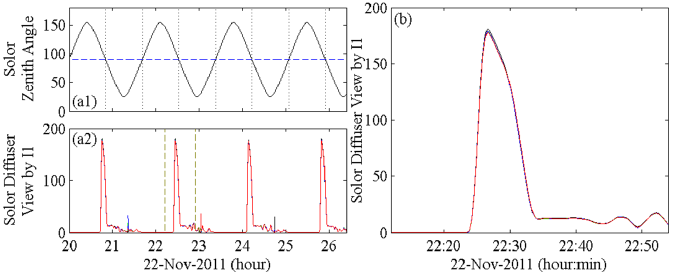
Figure 2. ( a1 ) Spacecraft solar zenith angle and ( a2 ) solar light illumination of VIIRS SD as seen by I1 channel detectors (overlaid together) over multiple orbits; and ( b ) zoom-in view of I1 view of SD.